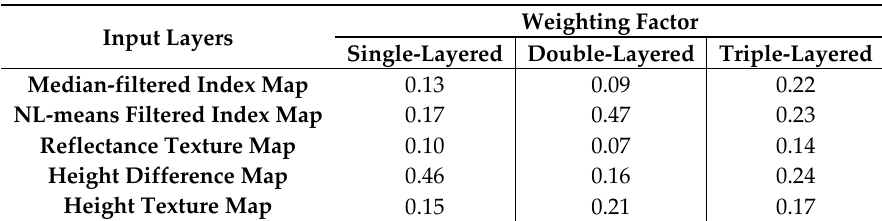
Table 1. Estimated weighting factor of the input layers.